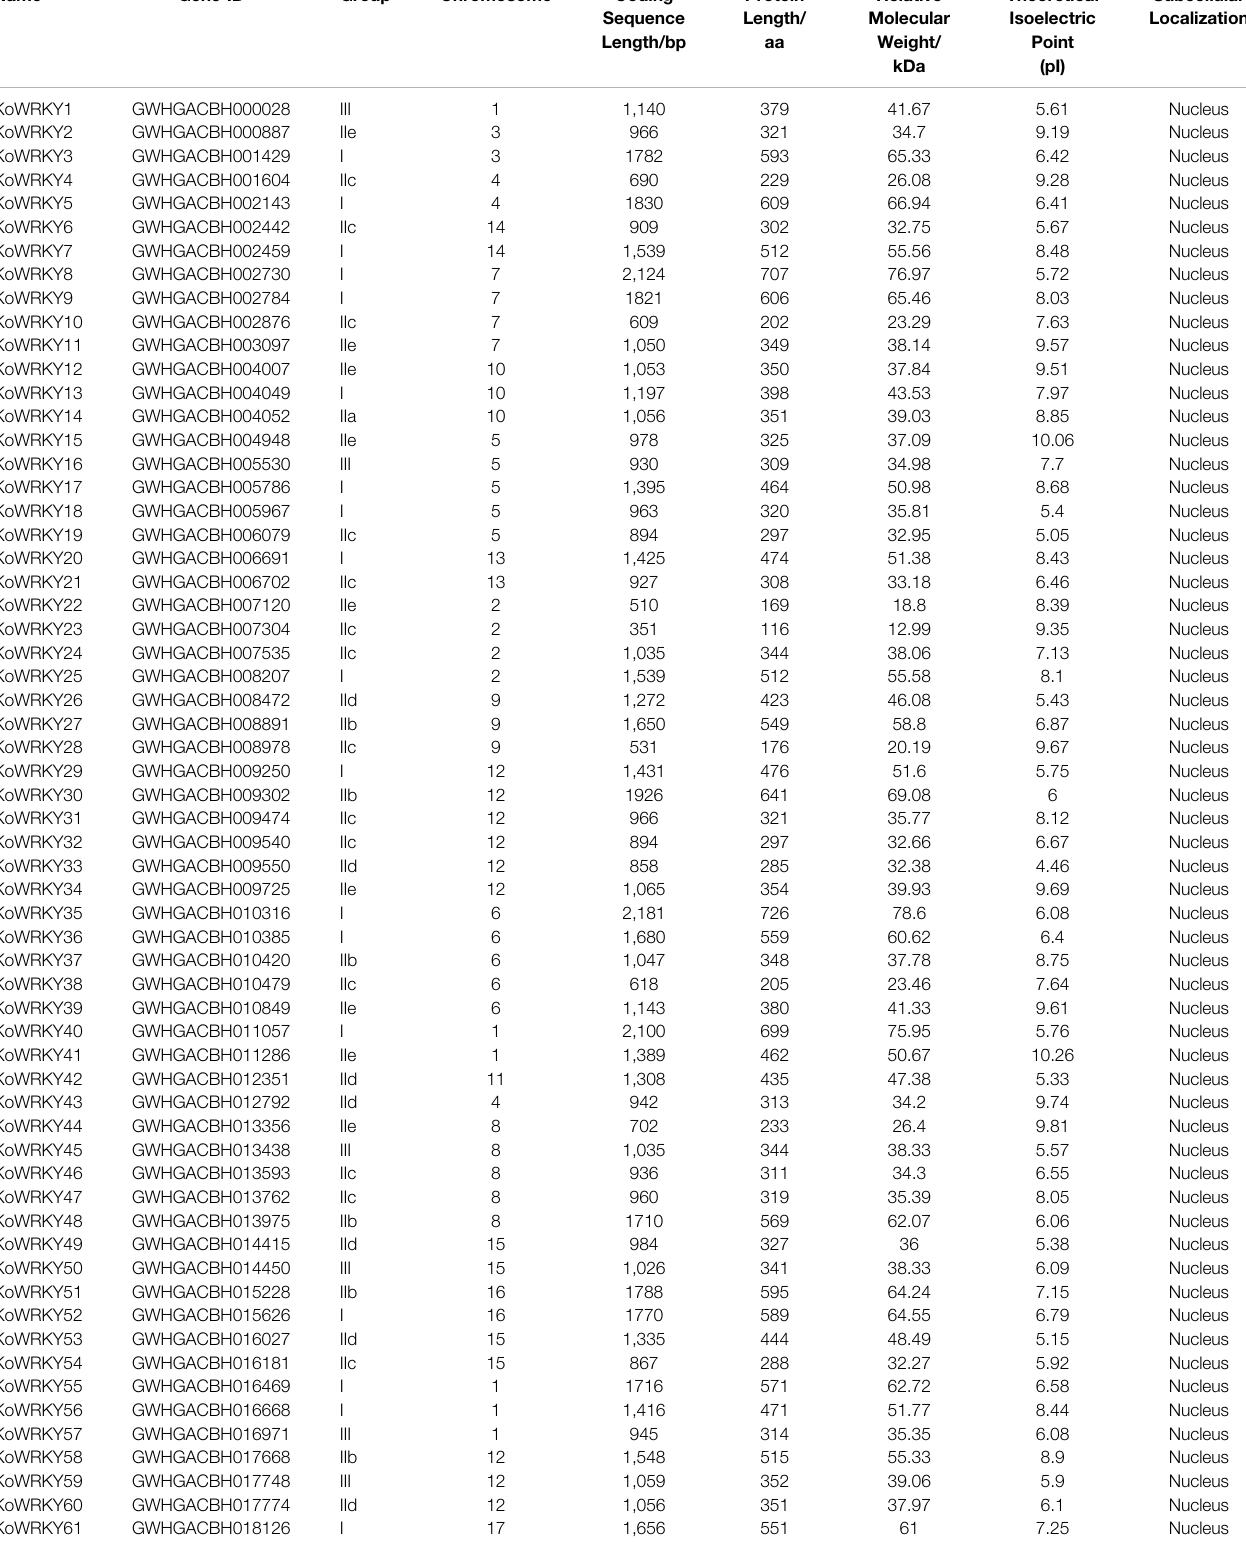
TABLE 1 | Annotation of Kandelia obovata WRKY transcription